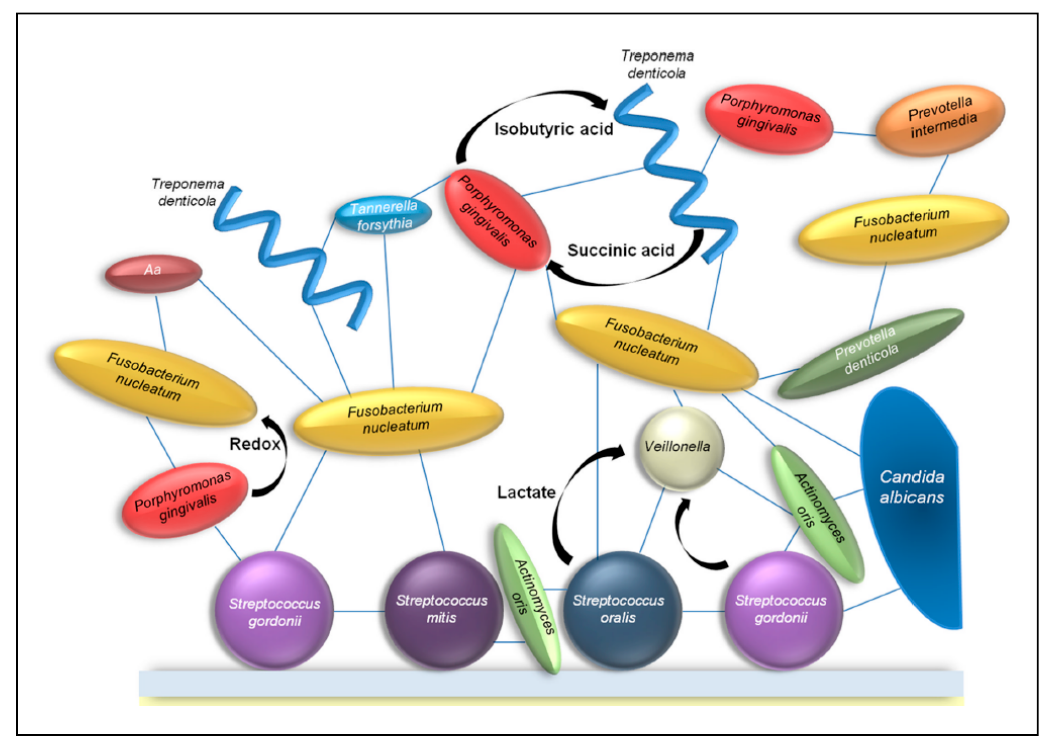
Figure 3. Example of several interactions in the oral biofilm. Each blue line indicates a physical interaction between different bacteria and fungi. The black arrows indicate the release of metabolic factors by one bacterium which is used by other bacteria. (Aa = Aggregatibacter actinomycetemcomitans ). Image taken from: [43] with permission.